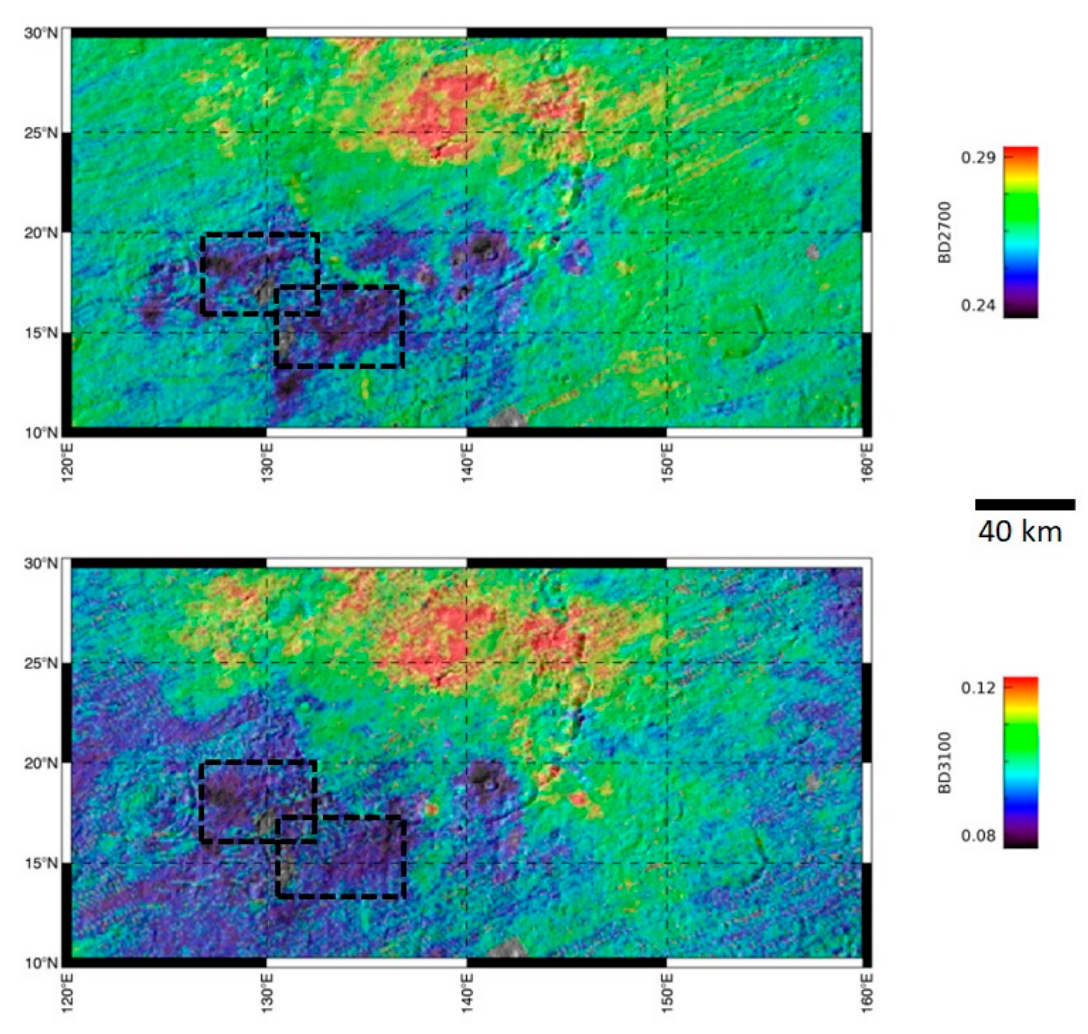
Figure 2. Distribution of the 2.7 and 3.1 μ m band depths in the Dantu region (cylindrical projection). The dotted squares enclose the linear features region. Scale bar refers to the latitude at the map center.